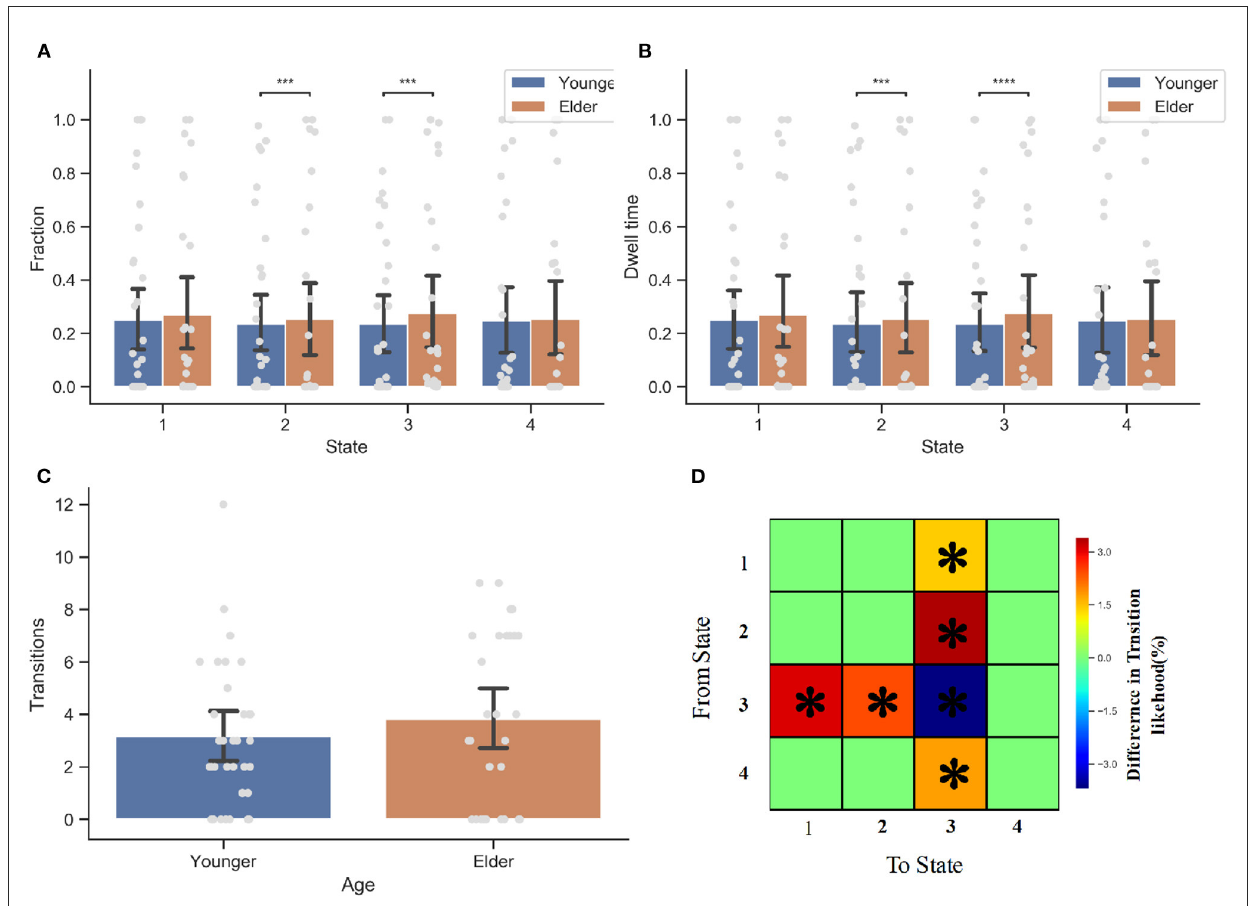
FIGURE5 Dynamic connectivity feature analysis for the elderly and younger groups. (A) The fraction of time the occurrence of DFC state 2 and state 3 has significant between group difference. The elder prefer state 2 ( P < 0.05) and state 3 ( P < 0.05). (B) The dwell time. Once again, the senior group is more like to stay within state 2 and state 3. (C) The number of transition between states. There is no significant difference in the number of state transition between two groups. (D) State Transition Probability matrix. Comparing with younger adults, the older people more inclined to switch to state 3 when they are in state 1, 2, or 4. However, they are also more likely to transfer to other state when they are entering state 3 than younger people. * p < 0.05, *** p < 0.001, and **** p < 0.001 FDR